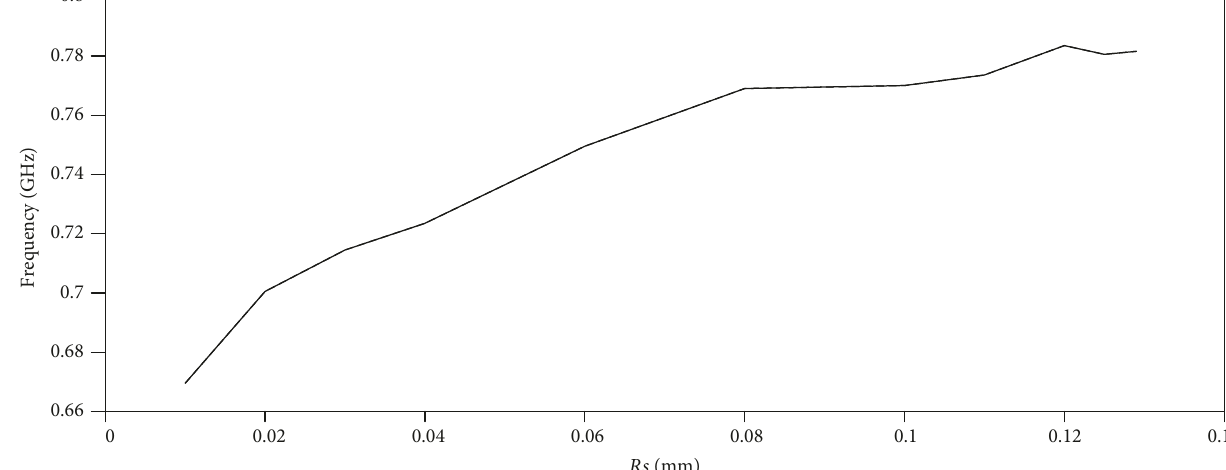
Figure 9: Simulation results for the resonant frequency dependence of the shorting post radius R